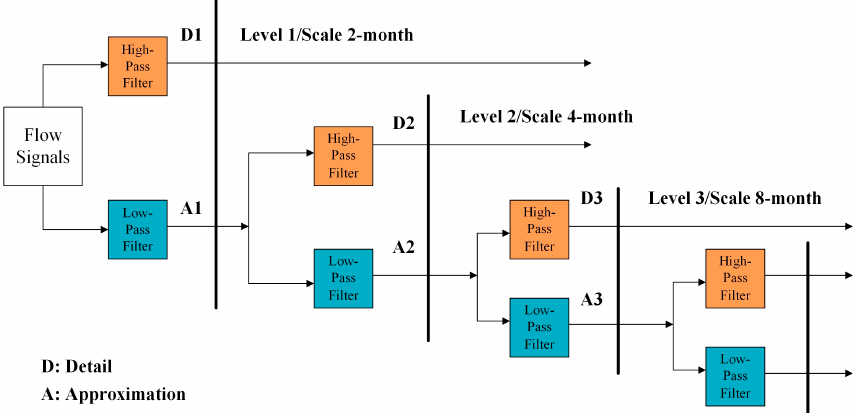
Figure 3. The discrete wavelet transforms (DWT) decomposition procedure of flow time series.